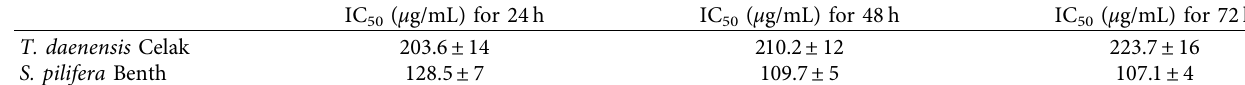
Figure 1: The experimental design of the study. Table 1: Calculated IC 50 values for both TDC and SBP plant extracts.